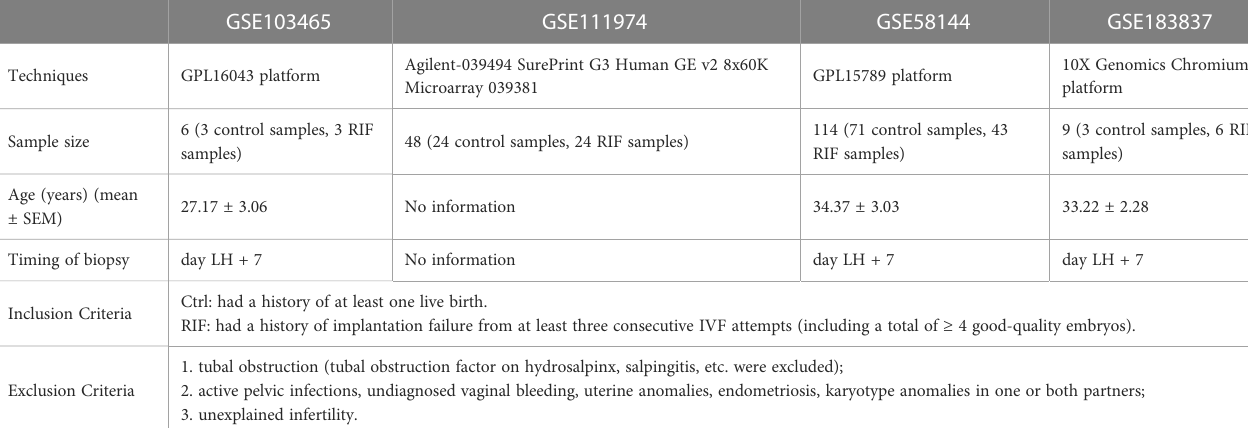
TABLE 1 Baseline